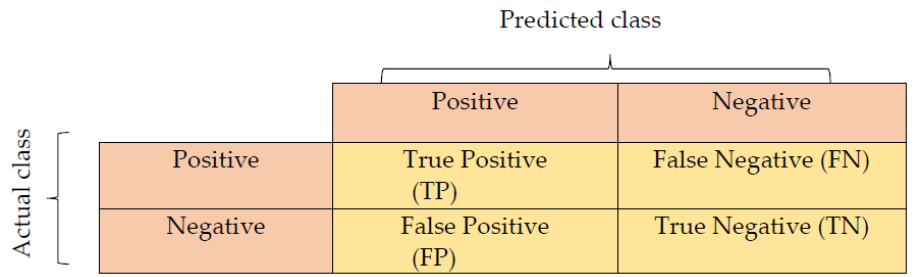
Figure 12. Confusion matrix table. Table 4. List of rates definition computed from the confusion matrix.